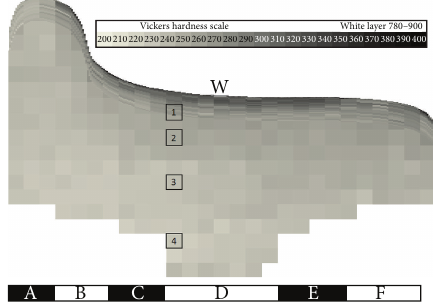
Figure 8: Hardness map for end-of-life regional DMU wheel. The numbers indicate locations of microstructure images shown in Figure